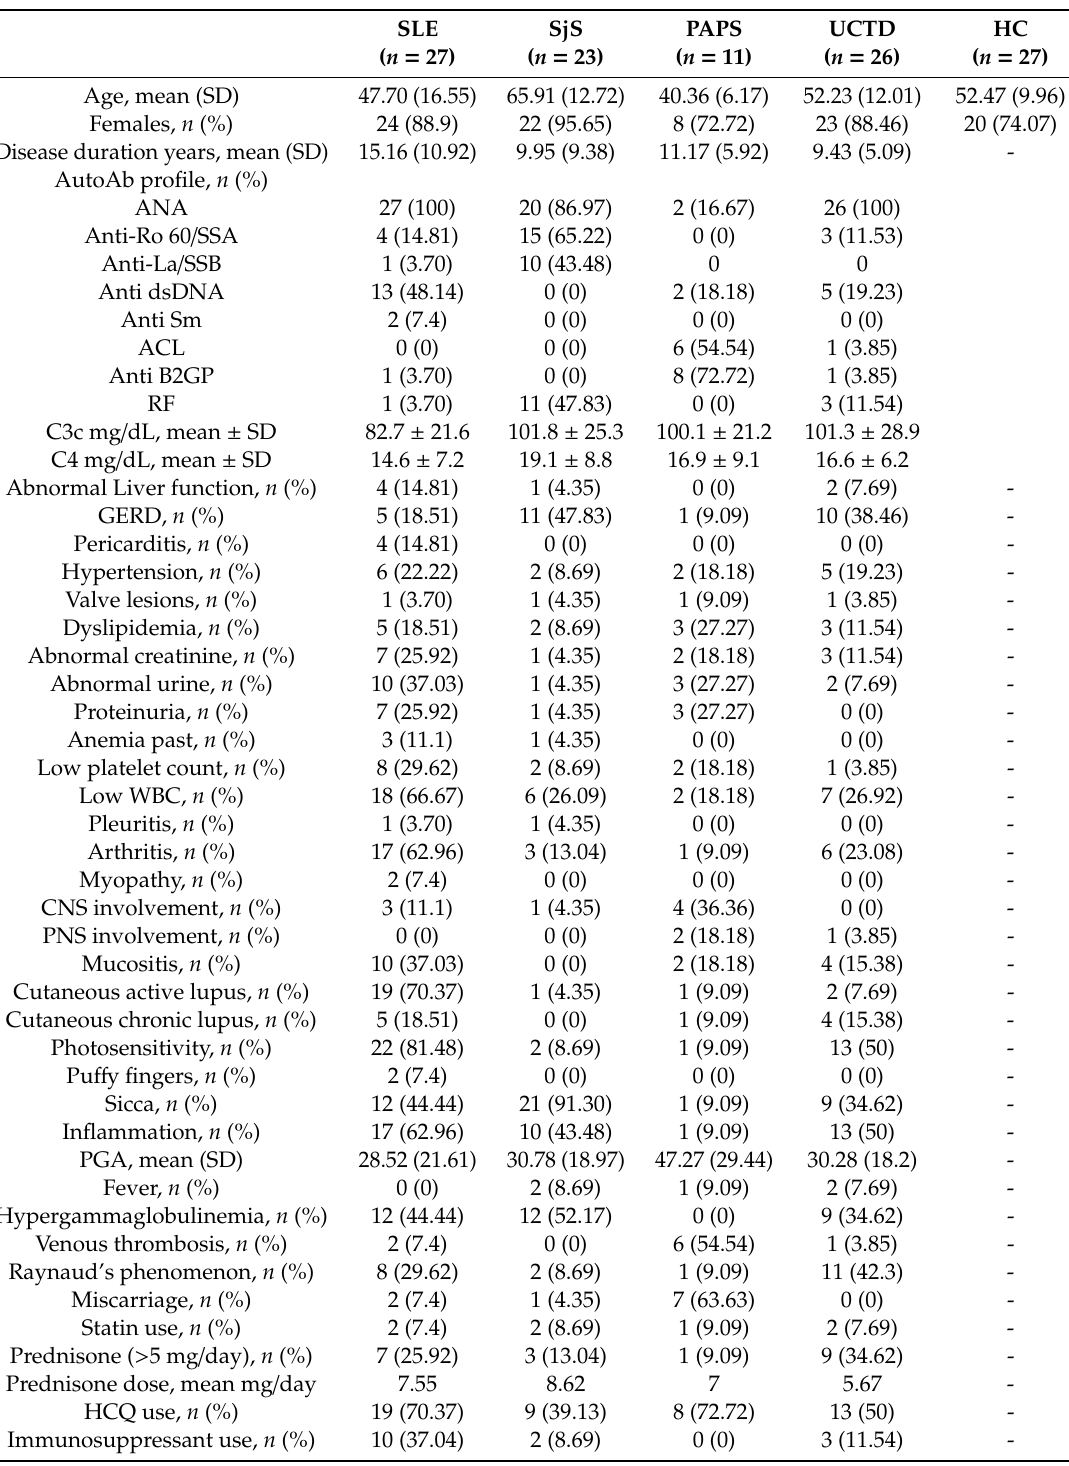
Table 1. Demographic and clinical characteristics of study